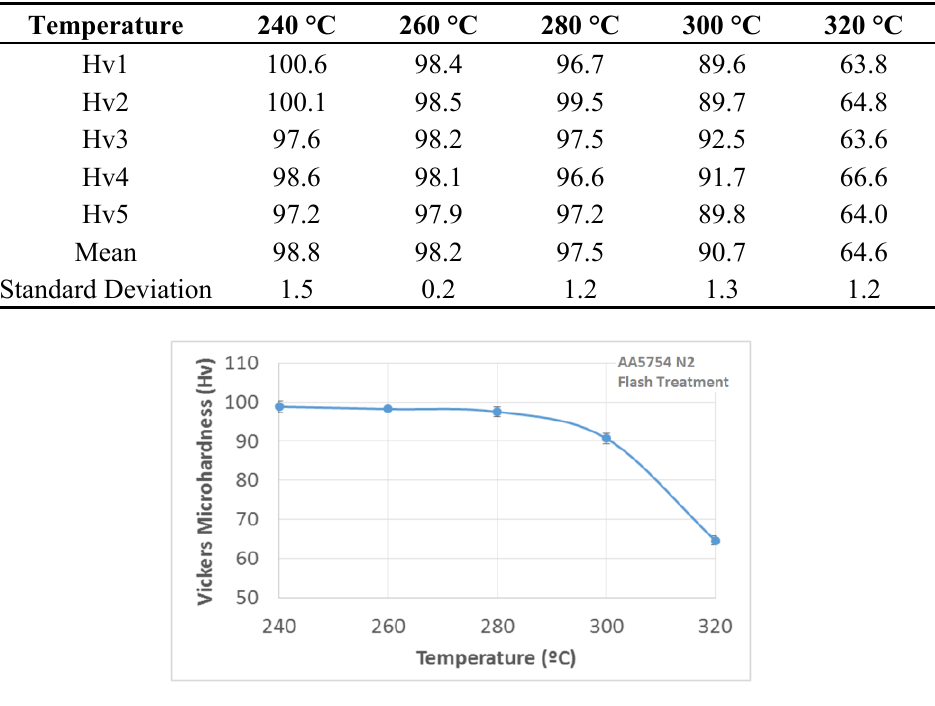
Figure 4. Hv microhardness vs. flash treatment temperature for the N2 starting